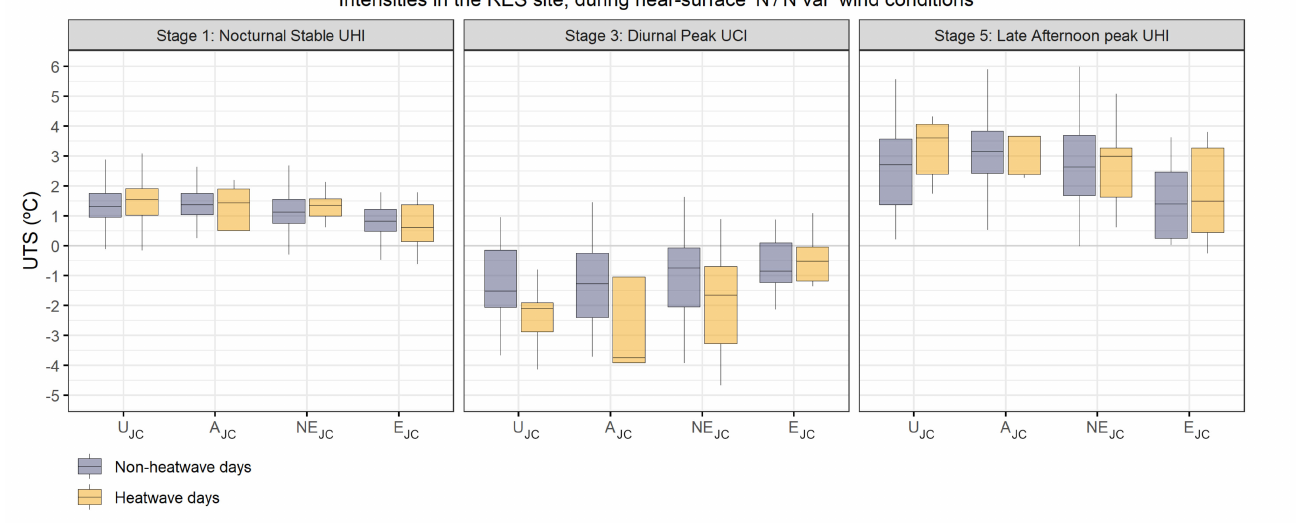
Figure 8. Urban thermal signal (UTS) per most frequent Jenkinson–Collison (JC) weather types during HW events; intensities in the RESs site (city center) during “N”/”N var” near-surface wind